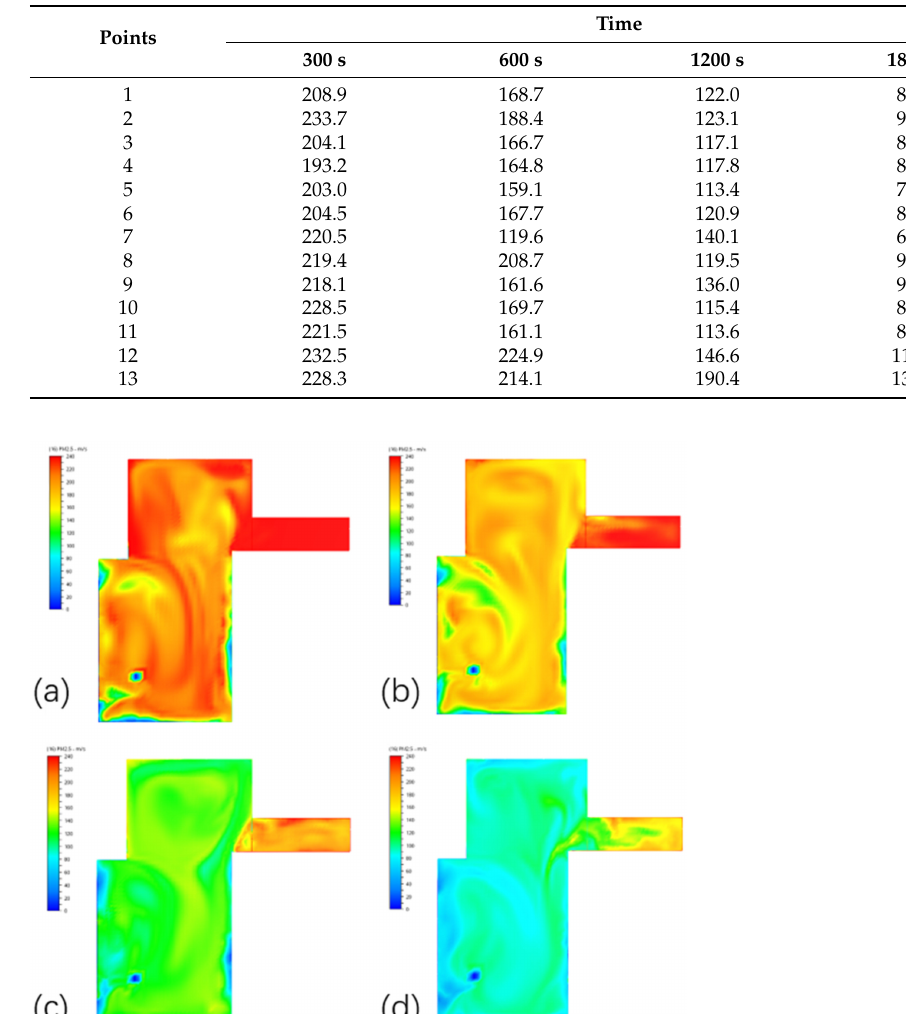
Figure A5. The simulation results of case 6 at the time of ( a ) 300 s; ( b ) 600 s; ( c ) 1200 s; ( d ) 1800 s. Table A5. Quantitative results of case 6.